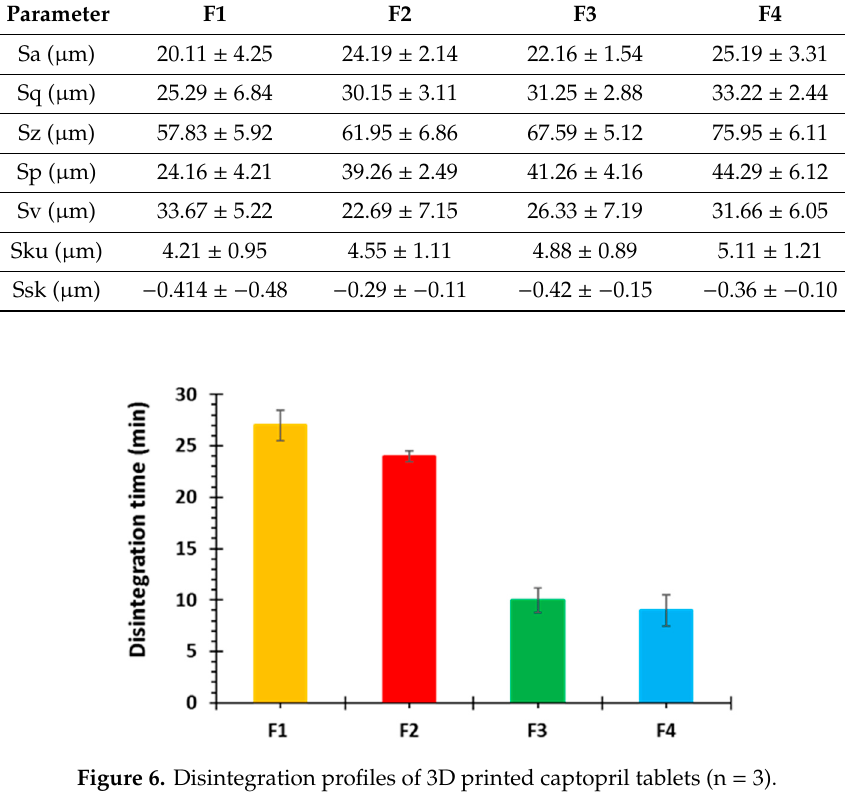
Figure 7. Dissolution profiles of captopril loaded filaments (n = 3).